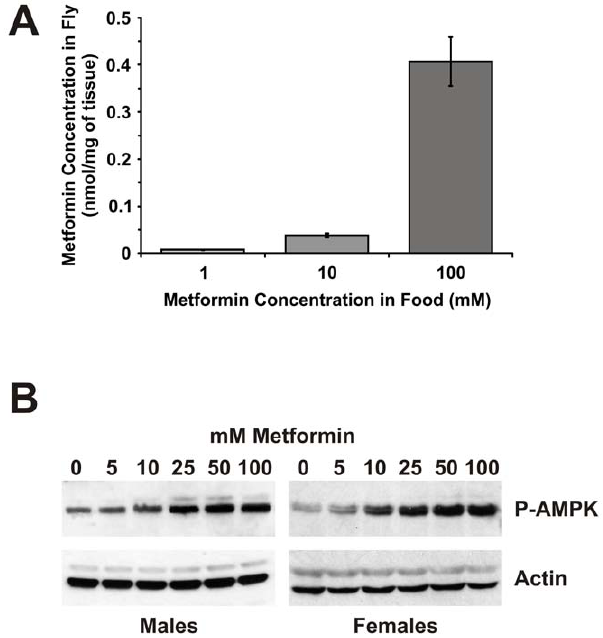
Figure 1. Metformin treatment of adult Drosophila activates AMPK. A. Mass spectrometric determination of metformin concentra- tion in whole fly extracts. Female flies were sampled after 7 days of metformin treatment at concentrations of 1, 10 and 100 mM. Before sampling, flies were incubated in the absence of metformin for 5 hours to allow for gut emptying. A dose-dependent increase in metformin accumulation in fly tissues was observed. Data are represented as the mean of three independent replicate samples 6 SEM. B. Western blot analysis of phospho-Thr172-AMPK expression in whole-fly protein extracts. Flies were sampled after 7 days of metformin treatment at concentrations of 0, 5, 10, 25, 50 and 100 mM. A dose-dependent increase in phospho-Thr172-AMPK levels was observed. Actin was used as a loading control.